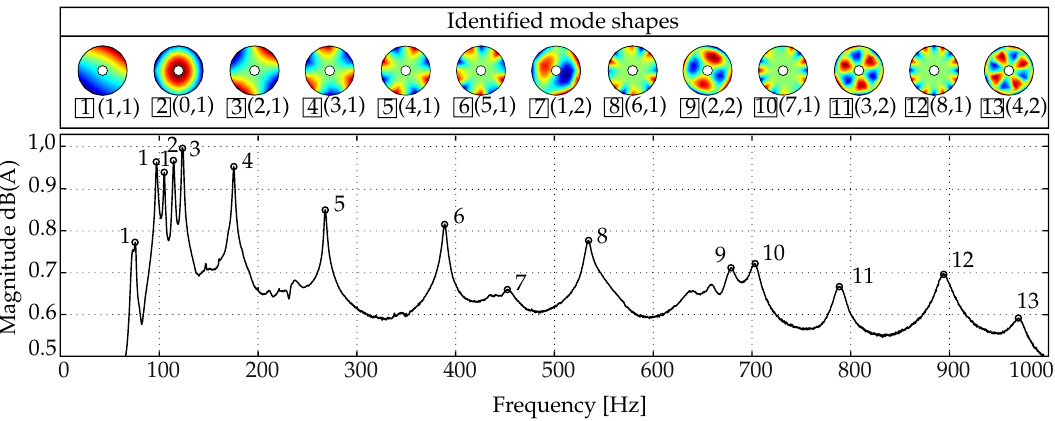
Figure 11. Display of mode shapes with associated frequency spectrum of a glass fibre rotor in its initial